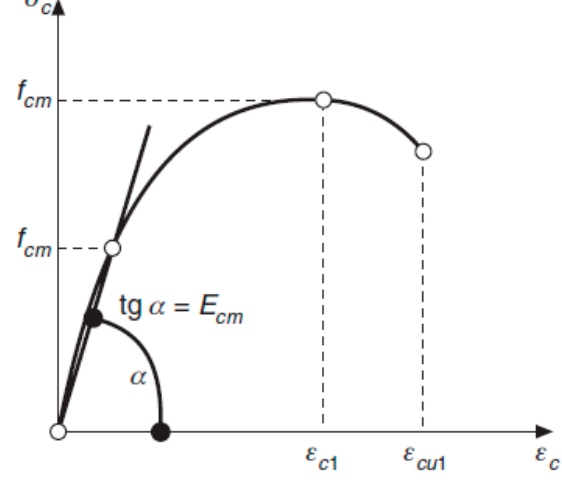
Figure 5. Stress-strain graph of concrete [29].